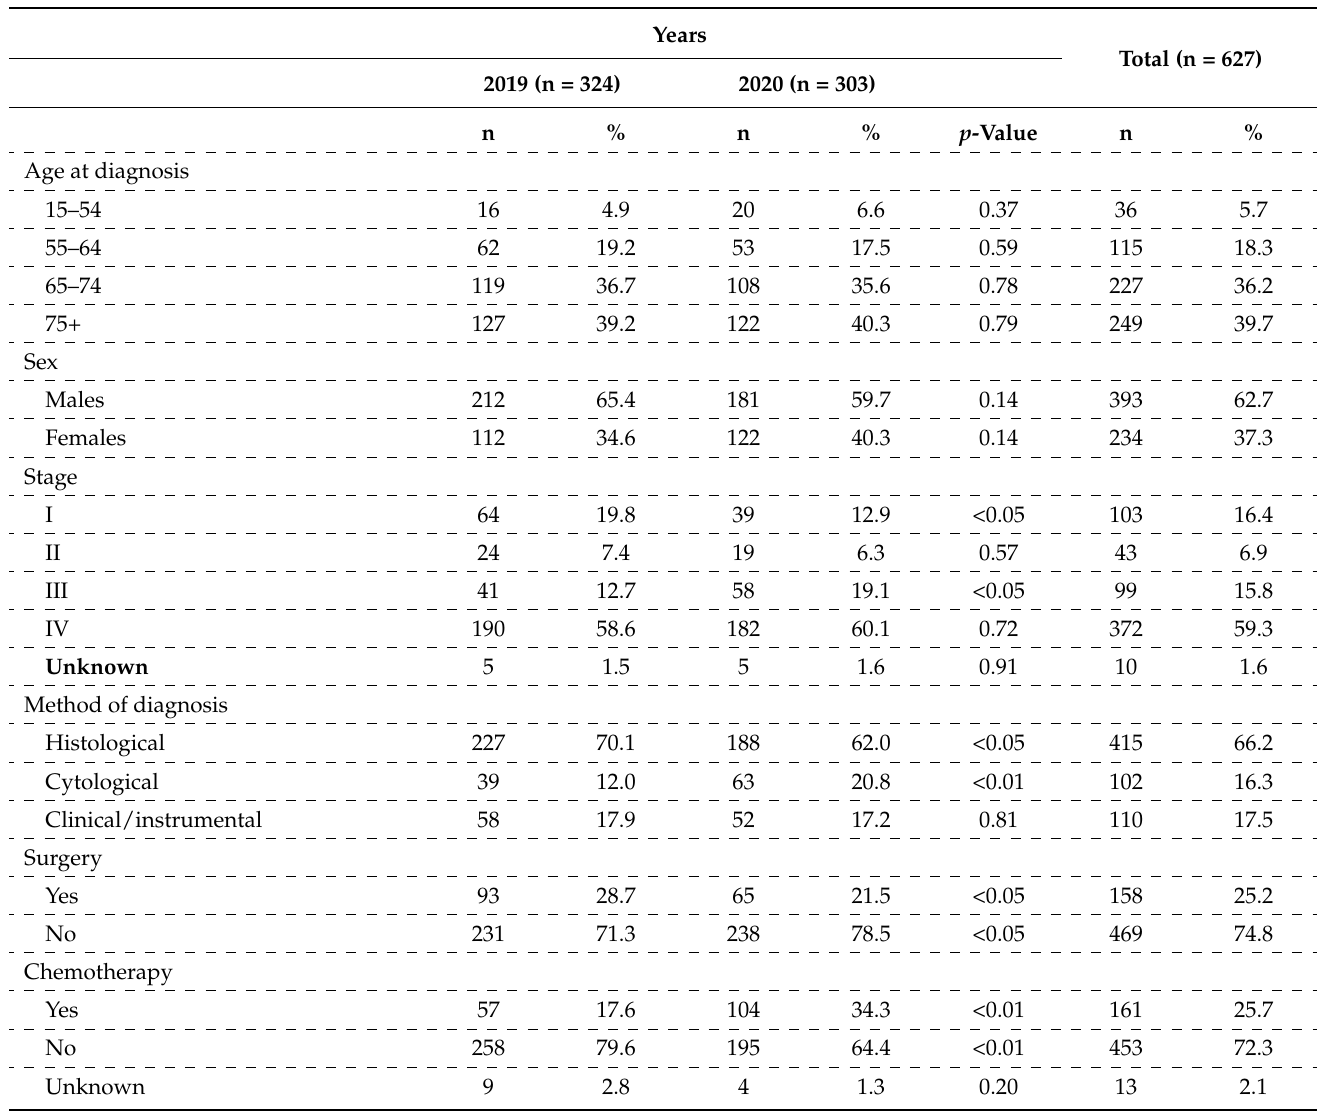
Table 1. Number of cases by age, sex, stage, method of diagnosis, and therapy, per year.